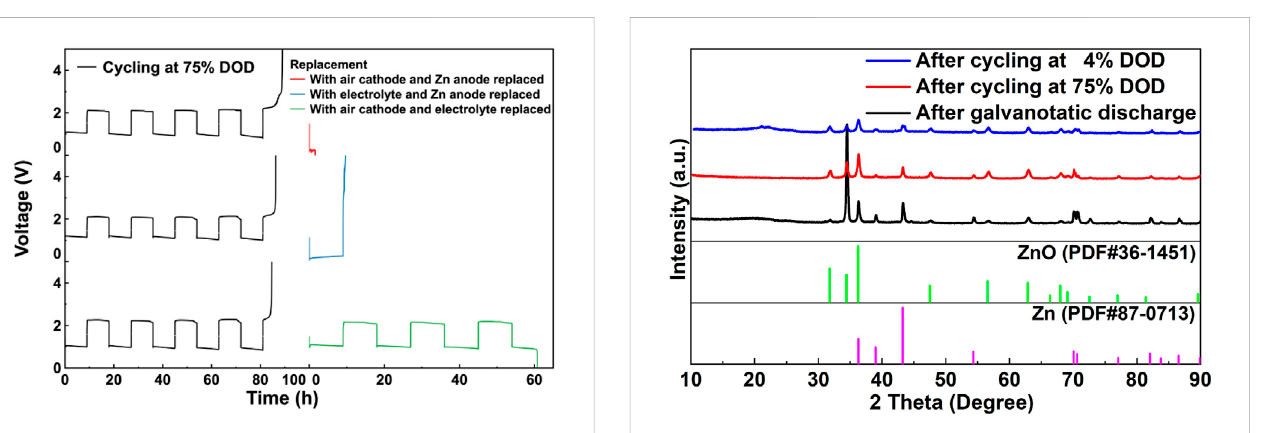
FIGURE 6 Replacement experiments. Galvanostatic charge/discharge cycle curves for ZABs and cycled ZABs with two components among Zn anode,electrolyteandCo